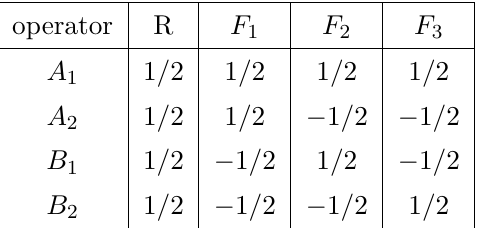
Table 3. UV R and flavor charges of the chiral multiplet